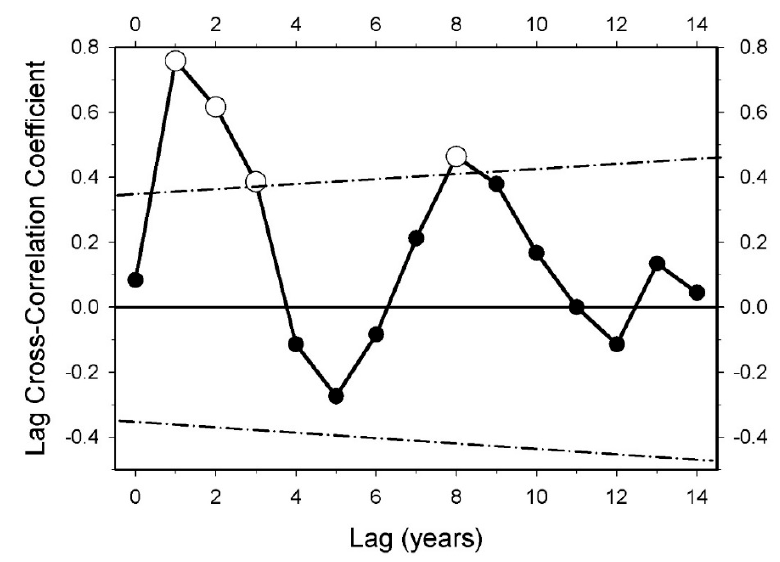
Figure 5. Lag cross-correlation between annual precipitation basin input and lake level. Precipitation leading lake level by the number of years is shown on the horizontal axis. The dotted lines represent the 95% confidence bounds.